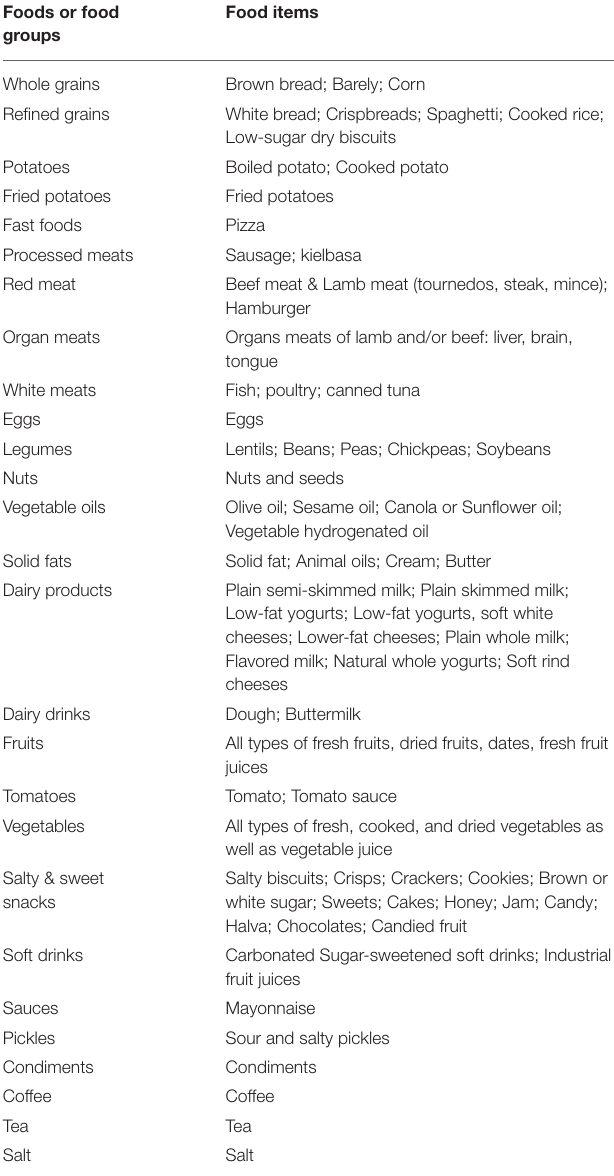
TABLE 1 | Components of food groups included in dietary